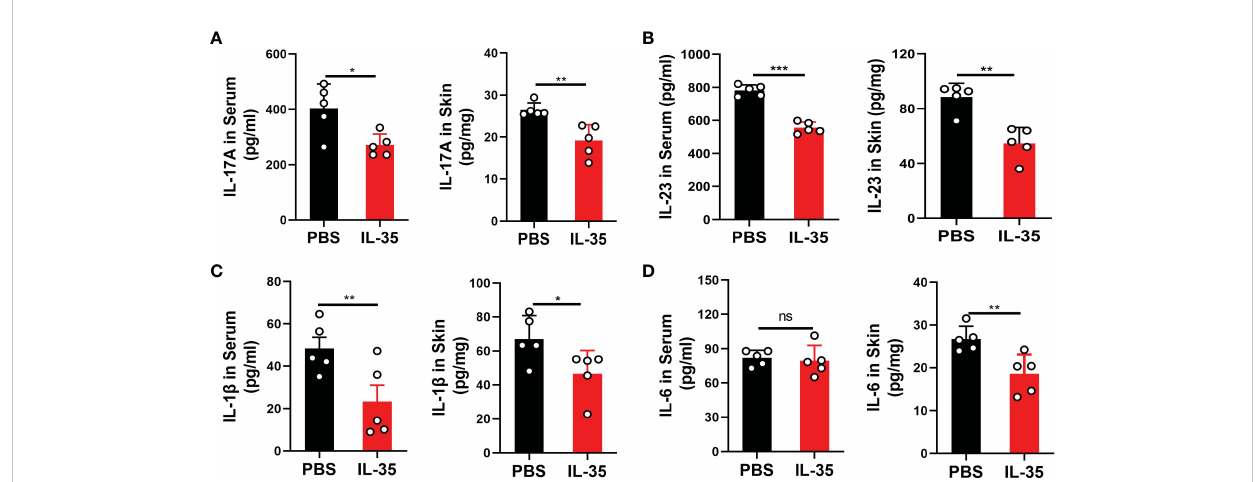
FIGURE 6 IL-35 inhibited the secretion of in fl ammatory cytokines in the serum and local lesions of mice with IMQ-induced psoriasis. Several proin fl ammatory cytokines were detected by ELISA in serum and skin tissue after IL-35 treatment. Cytokines in supernatants of extracted tissue protein were assayed and are presented as picograms of cytokine per milligram of tissue. (A) IL-17A, (B) IL-23, (C) IL-1 b , and (D) IL-6. Data are presented as means ± standard deviation from three independent experiments. *P < 0.05, **P < 0.01, ***P < 0.001. ELISA, enzyme-linked immunosorbent assay; IL, interleukin; IMQ, imiquimod; ns, not signi fi